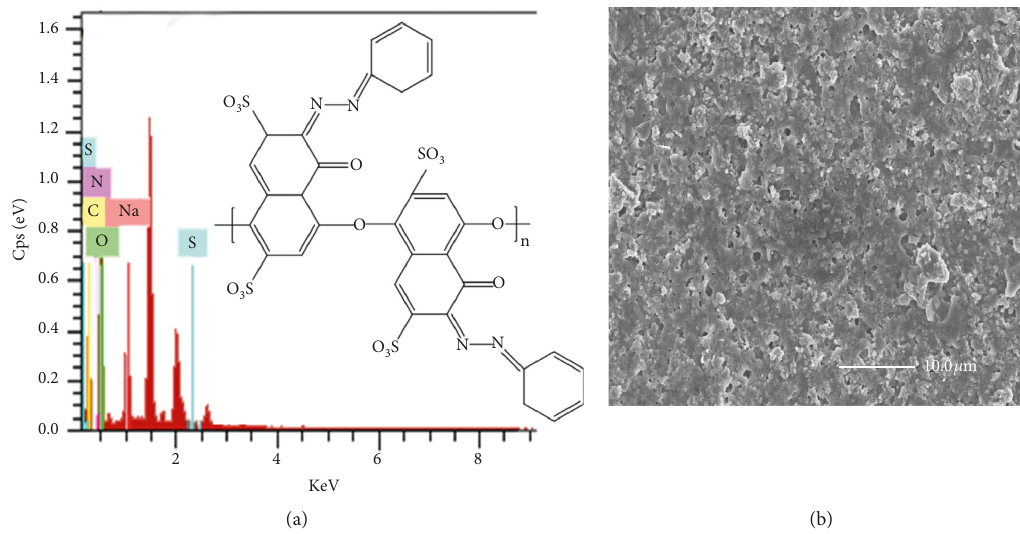
Figure 3: (a) EDS spectra and chemical structure (inset) of PCH. (b) SEM image of PCH